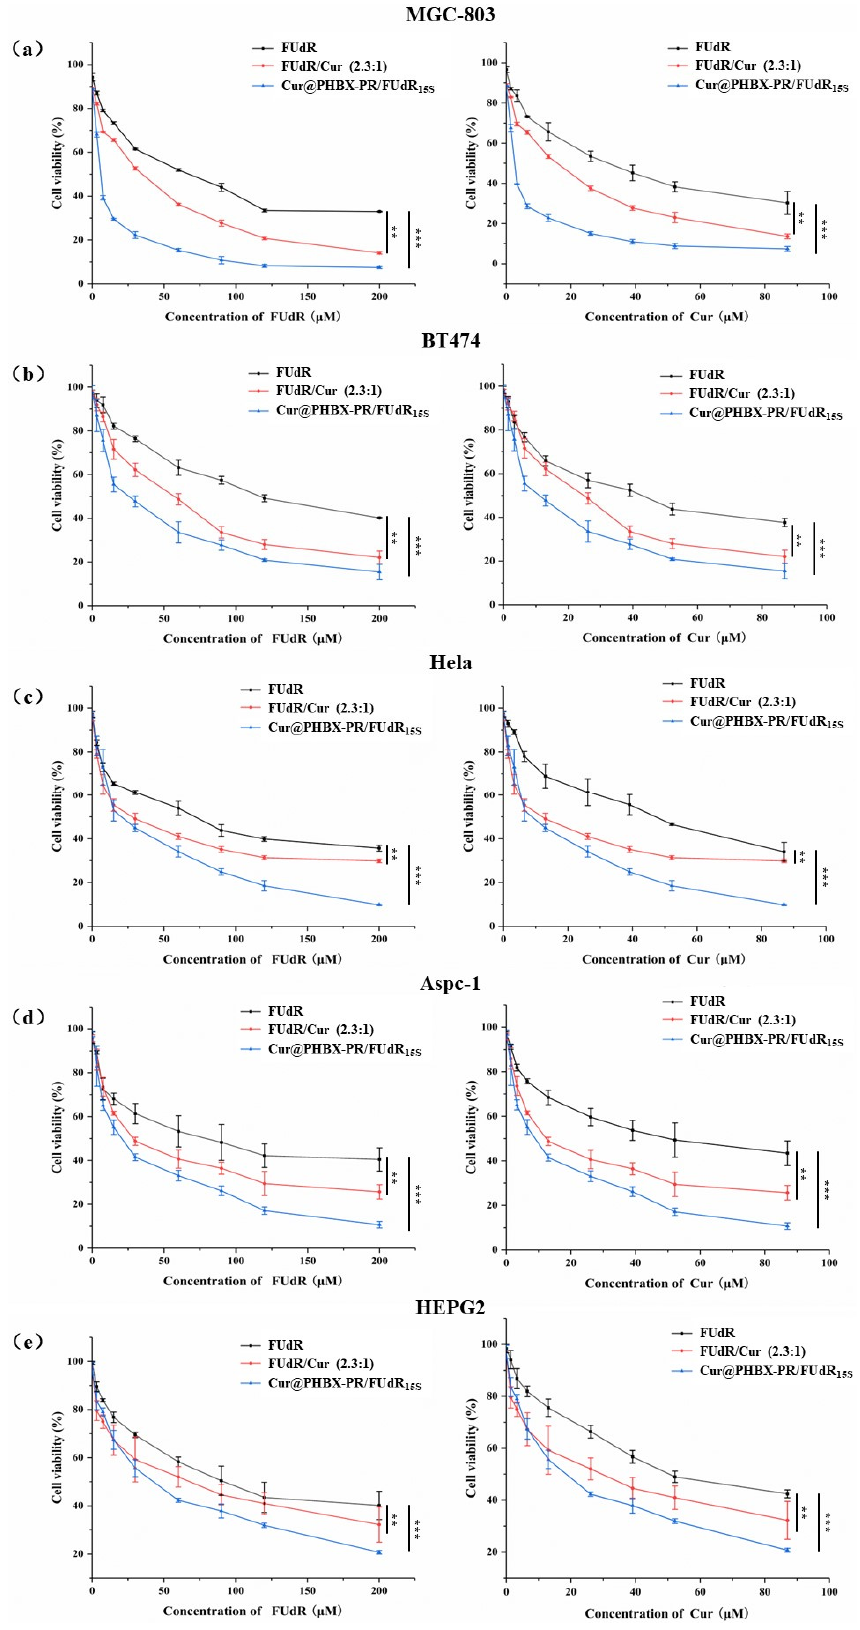
Figure 5. In vitro cytotoxicity assay. ( a ) MGC 803 cell was incubated with increasing concentrations of FUdR, FUdR/Cur 2.3:1, and Cur@PHBX-PR/FUdR 15S for 72 h. ( b ) BT474 cell was incubated with